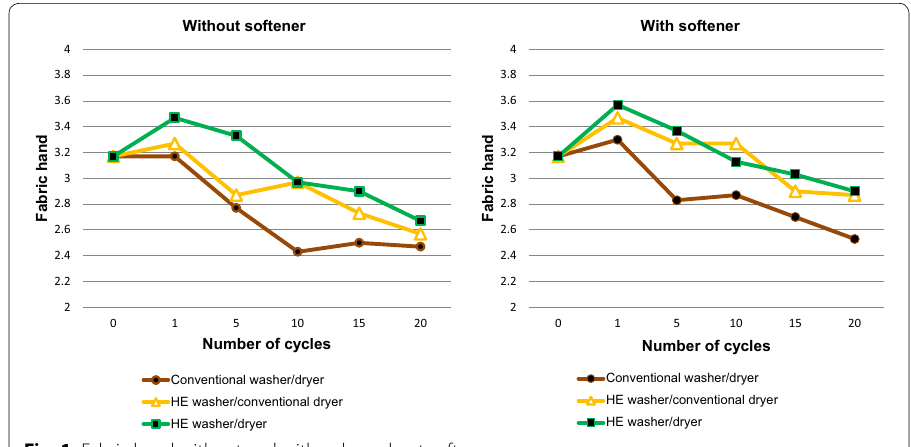
Fig. 1 Fabric hand without and with a dryer sheet